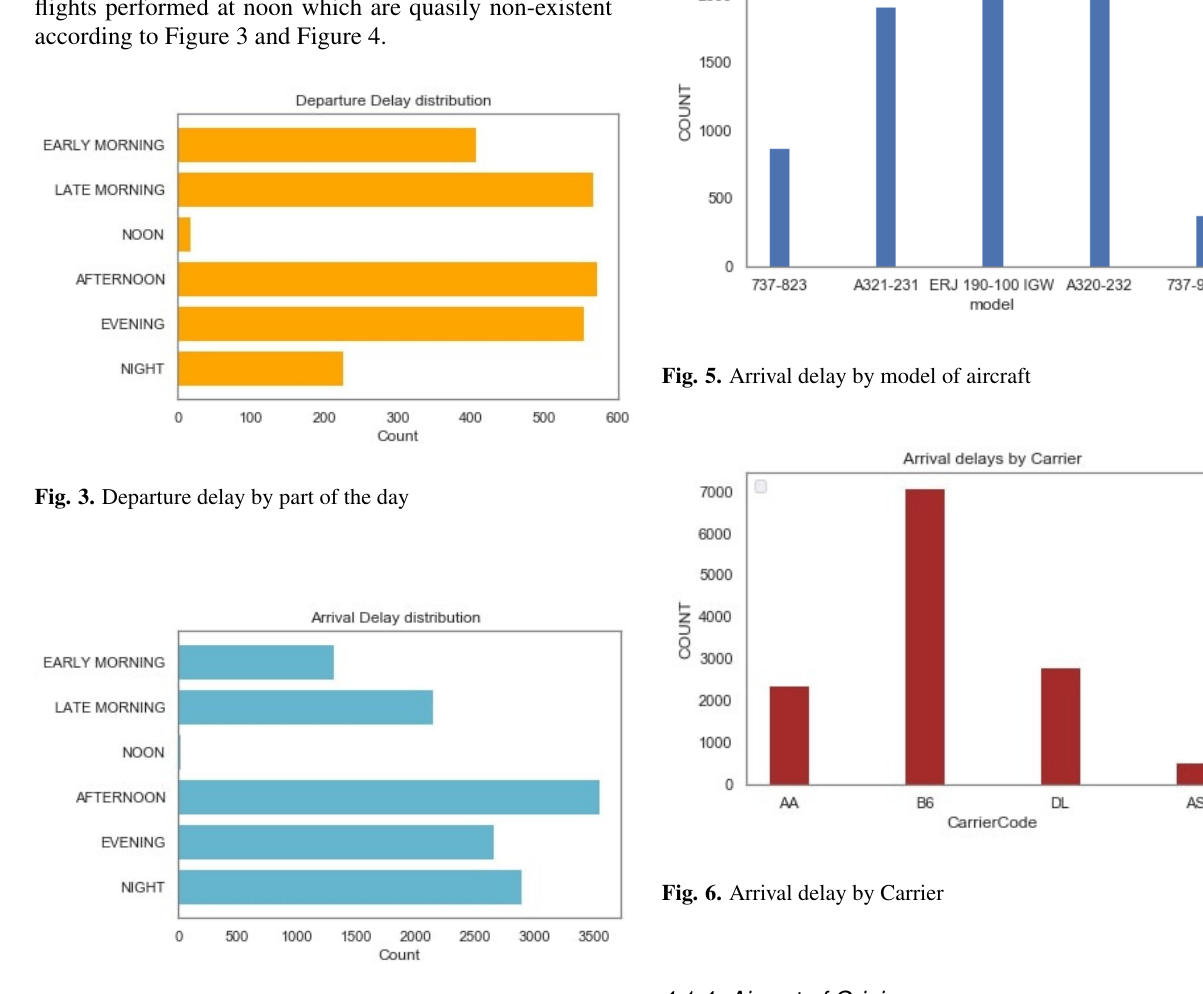
Fig. 4. Arrival delay by part of the day